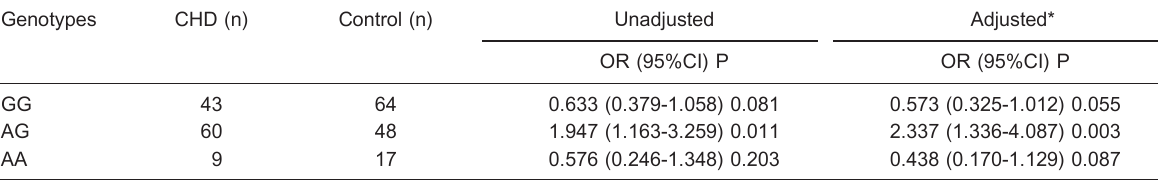
Table 5. Effect of rs1761667 polymorphism on coronary artery heart